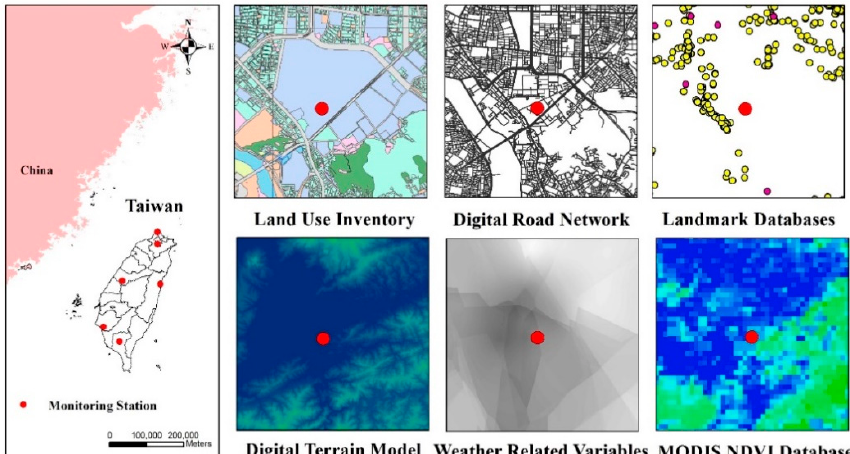
Figure 1. Overview of the six measurement sites and the illustrations of the collected geospatial databases.